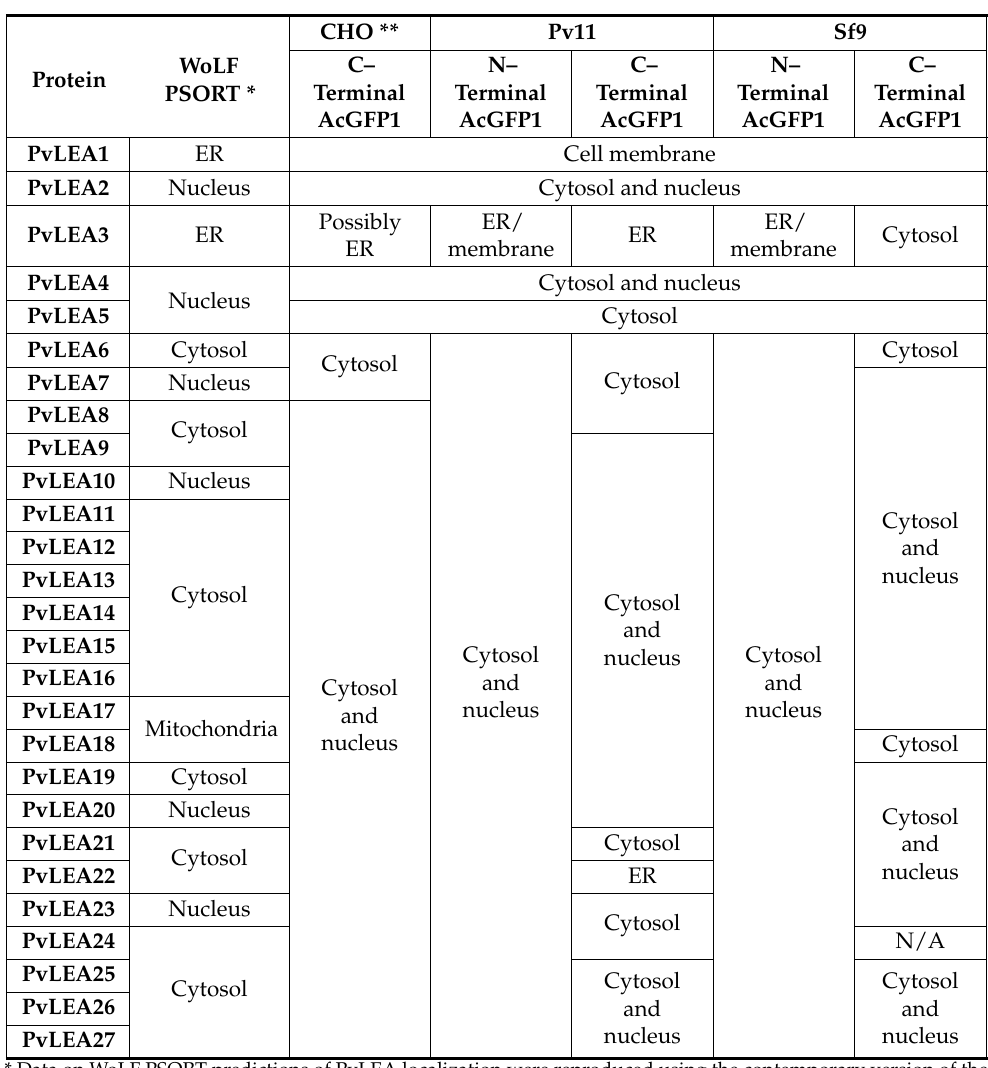
Table 1. Subcellular localization of PvLEA proteins in fusion with AcGFP1 in different cell cultures and WoLF PSORT predictions. We predicted the types of subcellular localization of different PvLEA proteins using WoLF PSORT and obtained experimental data with corresponding